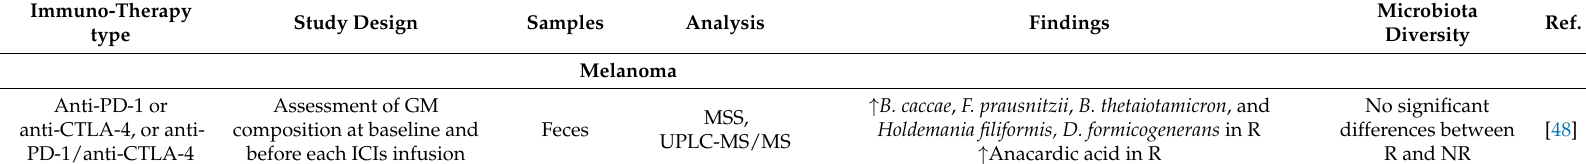
Table 1. Clinical trials investigating the effect of gut microbiota composition on ICI immunotherapy efficacy and therapeutic